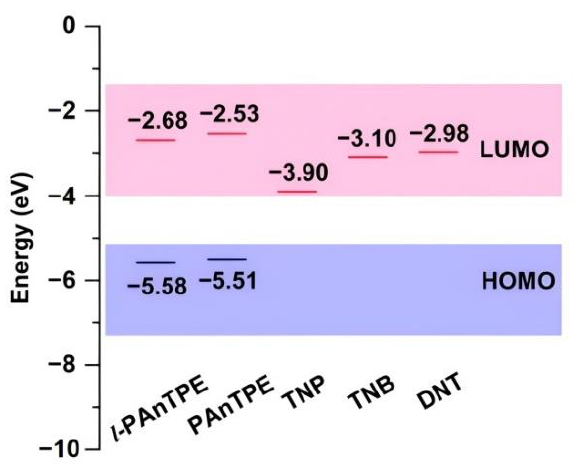
Figure 7. HOMO and LUMO energy levels of l -PAnTPE, PAnTPE and nitroaromatic explosives.